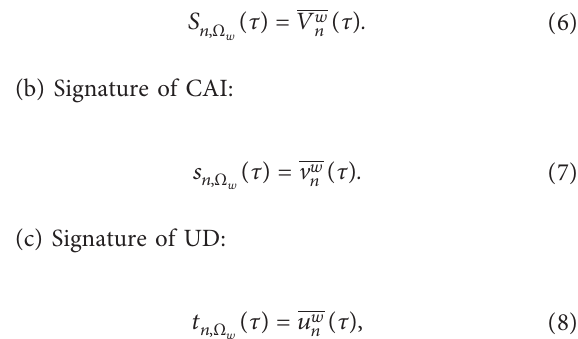
Table 2: POIs within 3rd Ring Road of Beijing.